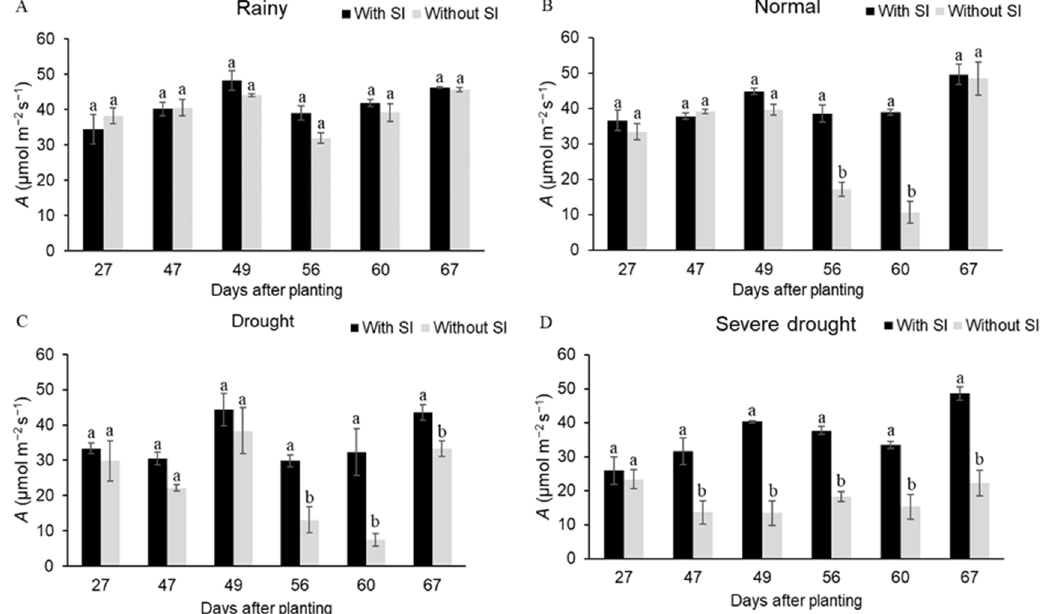
Figure 4. Net photosynthetic rate of maize leaves under Rainy ( A ), Normal ( B ), Drought ( C ) and Severe drought ( D ) scenarios, showing sampling date and presence or absence of supplemental irrigation (SI) with brackish water. For each sampling date, means followed by the same letters do not differ ( p ≥ 0.05) from each other according to the Tukey test. Error bars represent the standard error of the mean ( n = 4).